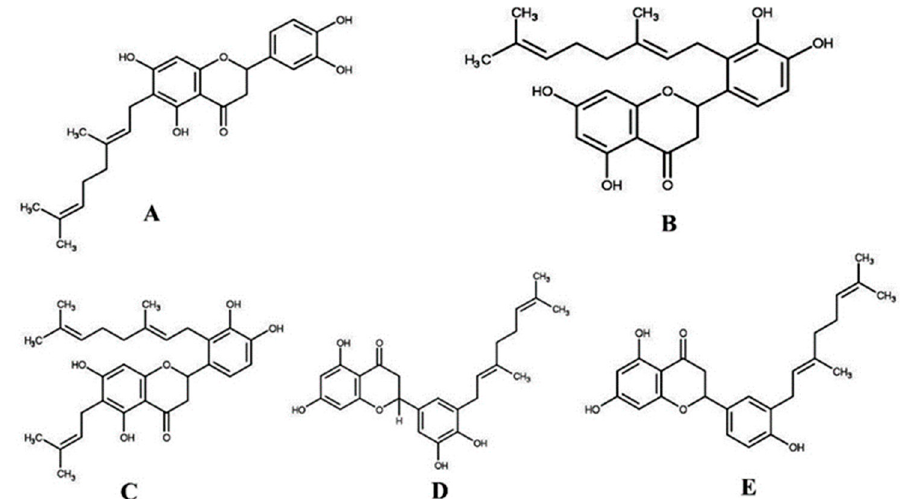
Figure 7. Chemical structures of the purified compounds from Okinawa propolis. ( A ) Nymphaeol-A (NA), ( B ) nymphaeol-B (NB), ( C ) nymphaeol-C (NC), ( D ) isonymphaeol-B (INB), and ( E ) 3 ′ -geranyl- naringenin (GN).